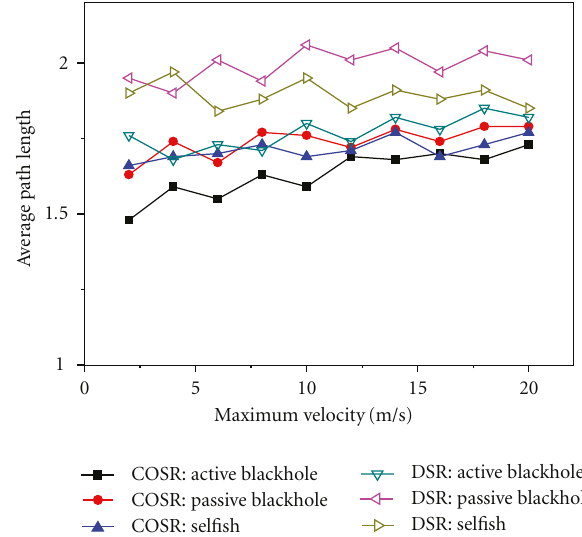
Figure 9: Throughput of COSR and DSR with various maximum velocity.